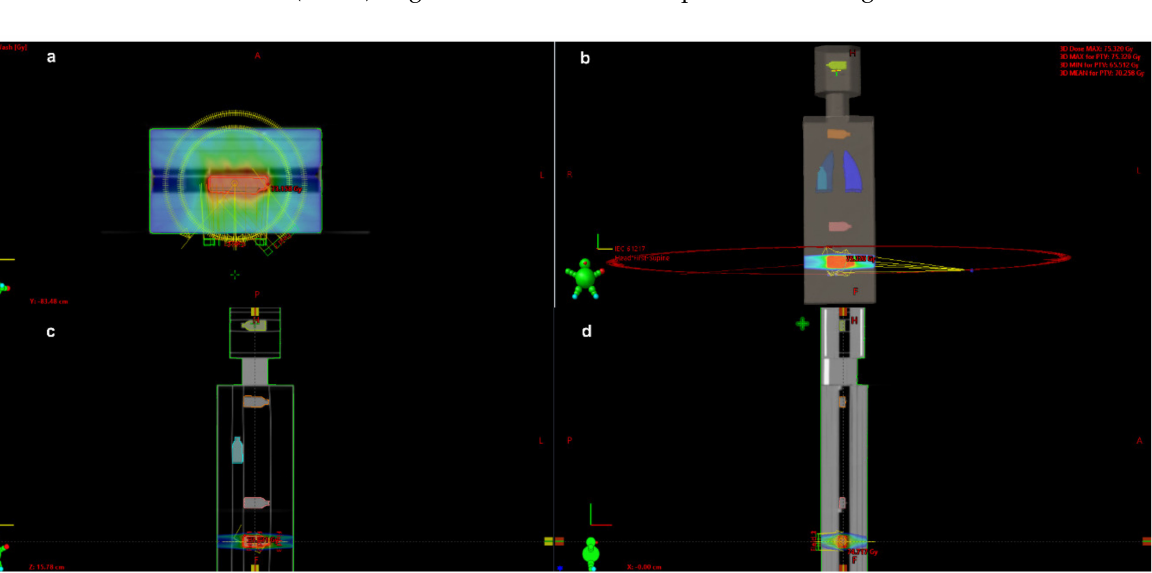
Figure 1. Transversal, 3D coronal, coronal and sagittal view of three co-planar arcs for VMAT plans. ( a ) transversal view; ( b ) 3D coronal view; ( c ) coronal view; ( d ) sagittal view. The plans were created intestine (red); right lung (blue); thyroid (orange); and brain